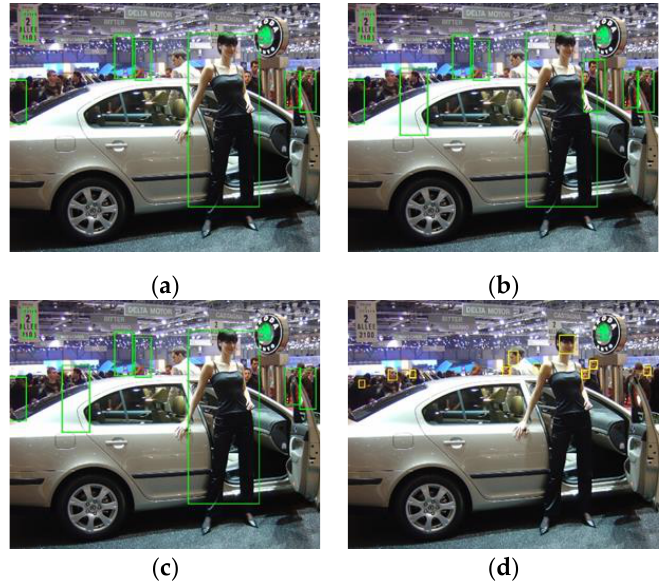
Figure 10. Detection results of the ACF detector ( a ), the integrated detector with 𝑟 𝑤 = 𝑟 ℎ = 0 ( b ) or 𝑟 𝑤 = 3 , 𝑟 ℎ = 8 ( c ) and the MTCNN detector ( d ). In ( b ), there are 2 more false positives than in ( a ), while ( c ) only has one more false positive.